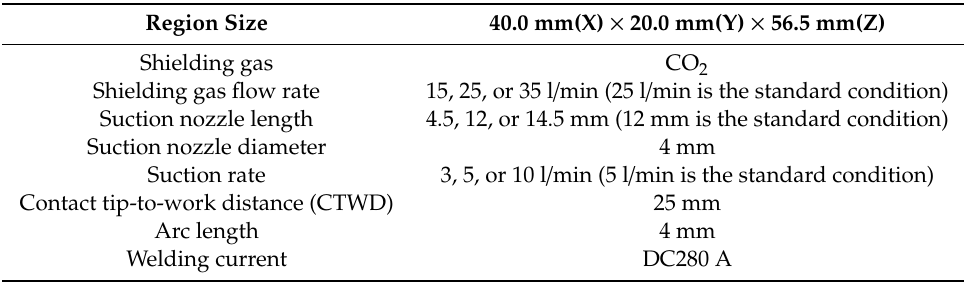
Figure 1. Schematic illustration of the simulation region. Table 1. Simulation conditions.